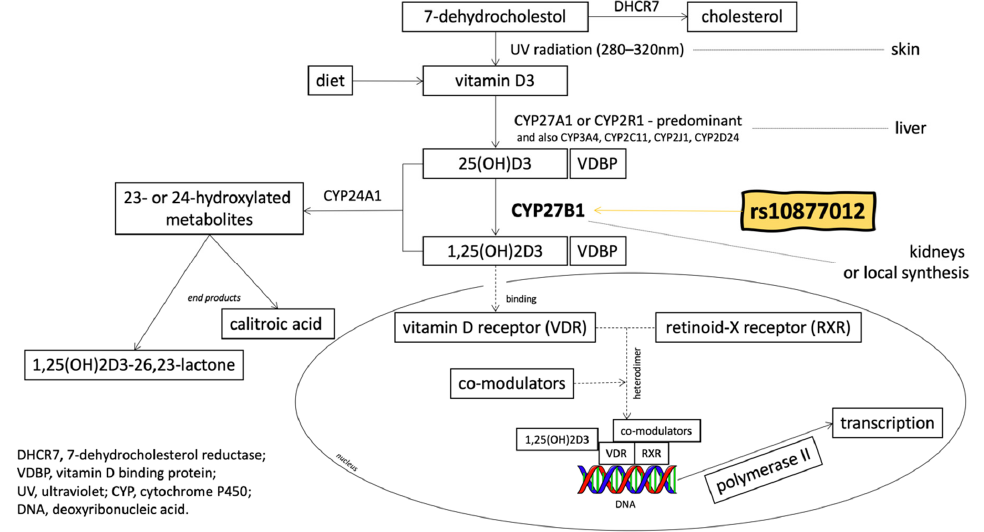
Figure 1. The metabolic pathway of vitamin D (based on Jenkinson 2019 [8] and on Feldman et al. 2014 [9], with